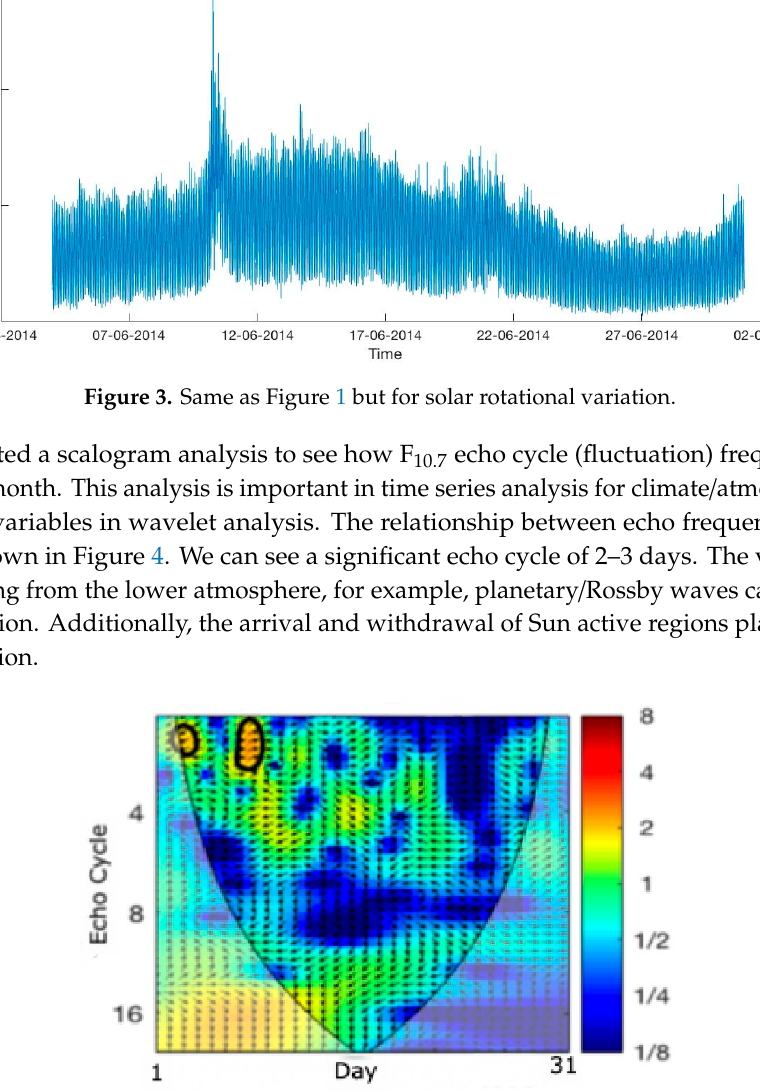
Figure 4. Scalogram between F 10.7 echo cycle frequency and density variation over a month (June 2014). Left (right) pointing arrows indicate that the two (antiphase) signals are in phase and down (up)–pointing arrows indicate that the density fluctuates (does not fluctuate). The density is constant, which does not fluctuate. If an arrow directs horizontally, then the density doesn’t fluctuate.